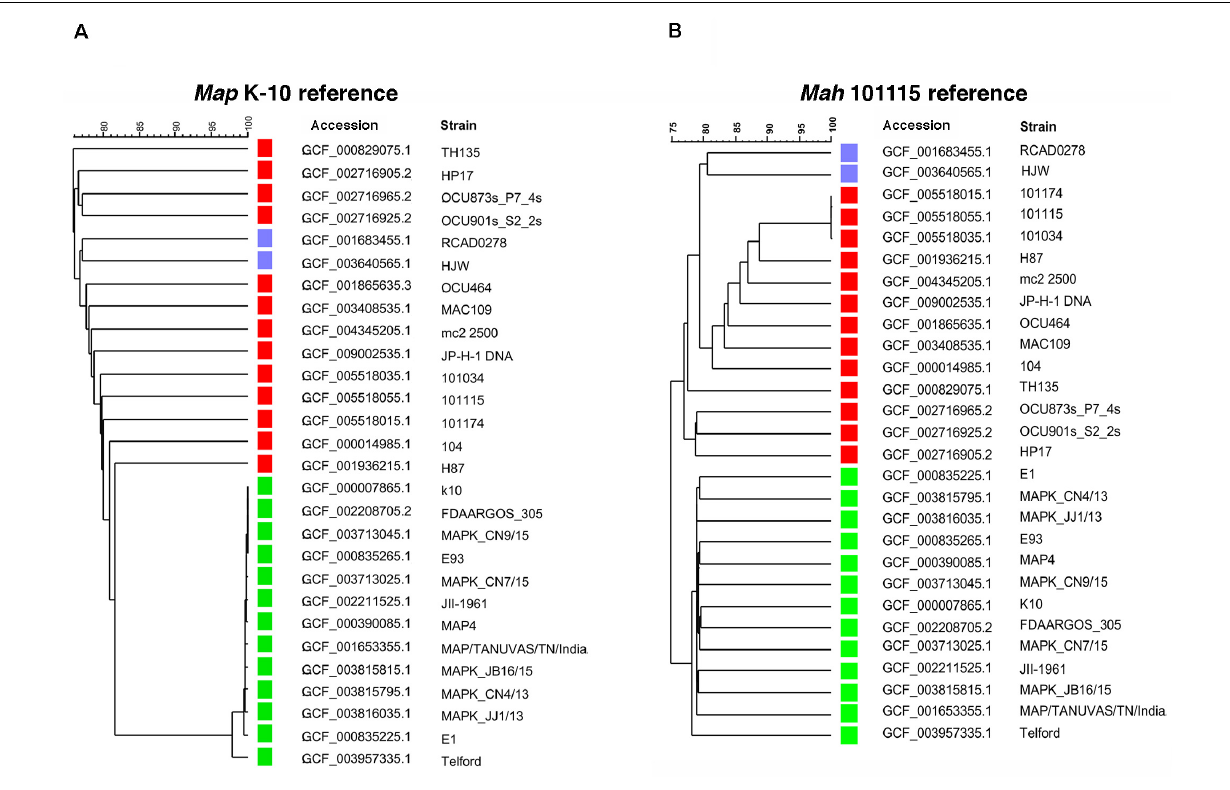
FIGURE 3 | UPGMA phylogenetic tree based on the total 65401 single nucleotide variants detected in all M. avium strains using Map K-10 as the reference (A) or based on the total 69324 SNPs detected using Mah 101115 as a reference (B) . The green squares represent Map stains while red and blue represent Mah and Maa strains, respectively. Scale at the top represents percent